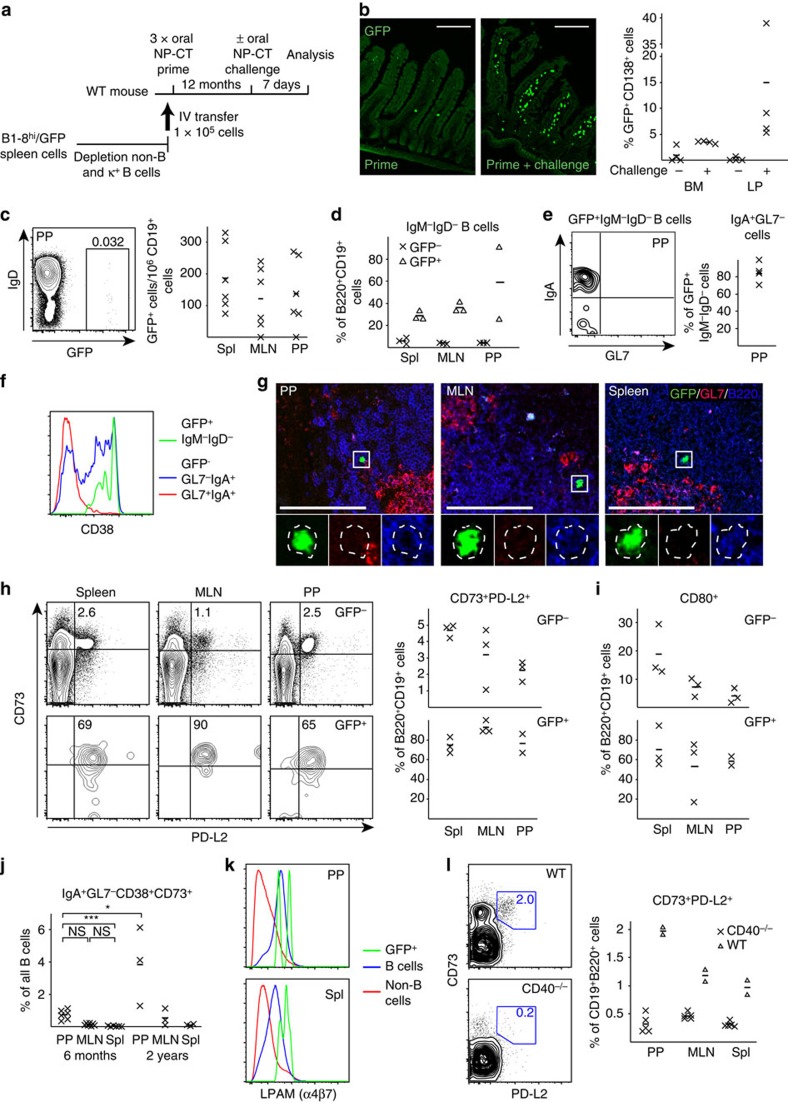
Orally primed memory B cells express CD80, CD73 and PD-L2 and reside in B-cell follicles in mucosal as well as systemic lymphoid tissues.(a) An adoptive transfer model with GFP+ NP-specific B cells was employed for monitoring memory B-cell development after oral immunization. Wild-type C57BL/6 mice were injected with 100,000 GFP+ λ-expressing NP-specific splenic B cells prepared from B1-8high/GFP mice, as described in the Methods section. (b) One year after oral priming immunizations with NP-CT (left) an oral booster immunization was administered and 7 days later (right) sections of gut LP were analysed for the presence of GFP+ NP-specific plasma cells by confocal microscopy. Flow cytometry analysis of the mean (−) and individual (x) frequency of GFP+CD138+ plasma cells in single-cell suspensions from the BM or SI LP. (c) Before the booster immunization, we determined the frequency of memory GFP+ NP-specific CD138−B220+CD19+ cells/106 total B cells in different tissues (spleen (Spl), MLN or PP) of six mice analysed individually by flow cytometry. (d) The proportion of GFP+ and GFP− CD138−B220+CD19+ B cells that had an IgM−IgD− isotype-switched phenotype in the indicated tissues. (e) The percentage of GFP+IgM−IgD− isotype-switched memory B cells from PP that expressed IgA in four individual mice. (f) Expression of CD38 on GFP+ memory B cells and GL7+ and GL7− IgA-expressing GFP− B cells in PP. (g, see also Supplementary Fig. 5b) Representative frozen sections analysed by confocal microscopy for GFP+ memory B cells (green) in the PP, MLN and Spl with germinal centres labelled with anti-GL7-eFlour 660 (red) and B-cell follicles with anti-B220-biotin/Streptavidin-Alexa Flour 594 (blue). Below the main panels are channel-separated close-ups to demonstrate that the GFP+ cells are B220+, but do not express GL7. (h) Flow cytometry analysis for CD73 and PD-L2 expression on CD138−B220+CD19+ GFP+ memory B cells isolated from indicated tissues. For comparisons, GFP− B cells are shown. The percentage of CD73+PD-L2+ memory B cells in three individual memory mice is depicted (right). (i) The frequency of CD80-expressing GFP+ memory B cells. (j) The percentage of B cells from the PP, MLN or Spl with a memory IgA+IgM−IgD−CD73+CD38+GL7− phenotype in 6 months (left) or 2-year-old (right) unimmunized mice. (k) Expression of the gut homing α4β7 receptor (LPAM integrin) in GFP+ memory B cells, as opposed to that found in GFP− B cells or non-B cells in the PP and Spl. (l) Lack of CD73+PD-L2+-expressing CD19+ B cells from the PP, MLN or Spl in CD40−/− mice. Representative data from groups of two to six mice and two to four independent experiments giving similar results. Mann–Whitney test and P values are given (not significant (NS) P>0.05, *0.01≤P<0.05, **0.005≤P<0.01, ***0.001≤P<0.005).